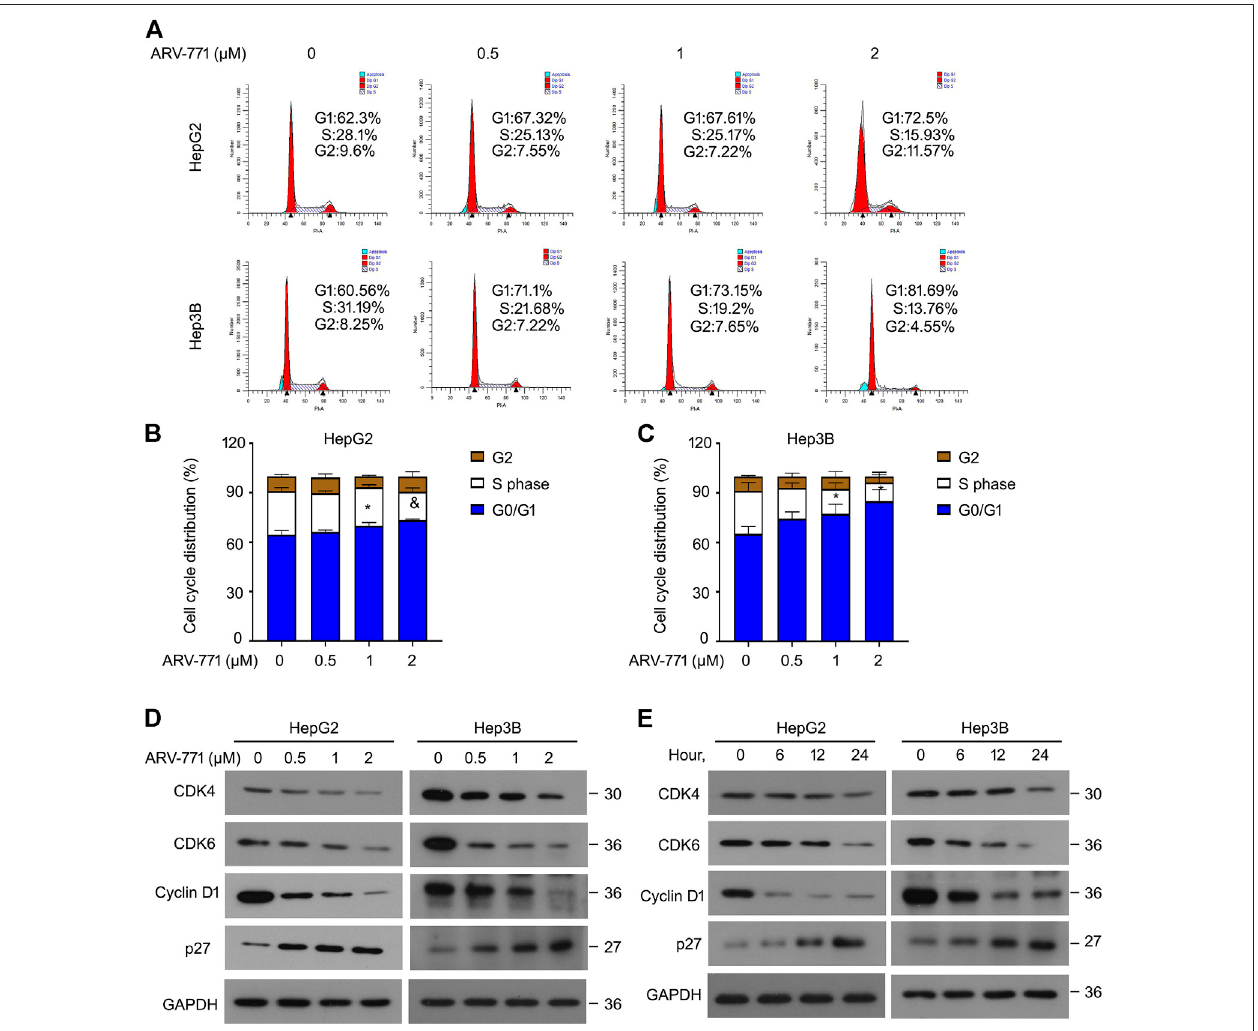
FIGURE 2 | ARV-771 postpones cell cycle transition in HCC cells. (A) Cell cycle assays were conducted in the indicated HCC cells exposed to ARV-771 for 24 h (B) – (C) Quantitative cell cycle distributions in the indicated HCC cells. * p < 0.05, & p < 0.01. (D) Immunoblot assaysfor the indicated cell cycle players were performed in HepG2 and Hep3B cells treated with ARV-771 (0.5, 1, 2 μ M) for 24 h. (E) Immunoblot assays for the indicated cell cycle players were performed in the indicated HCC cells exposed to ARV-771 (2 μ M) for 6, 12, and 24